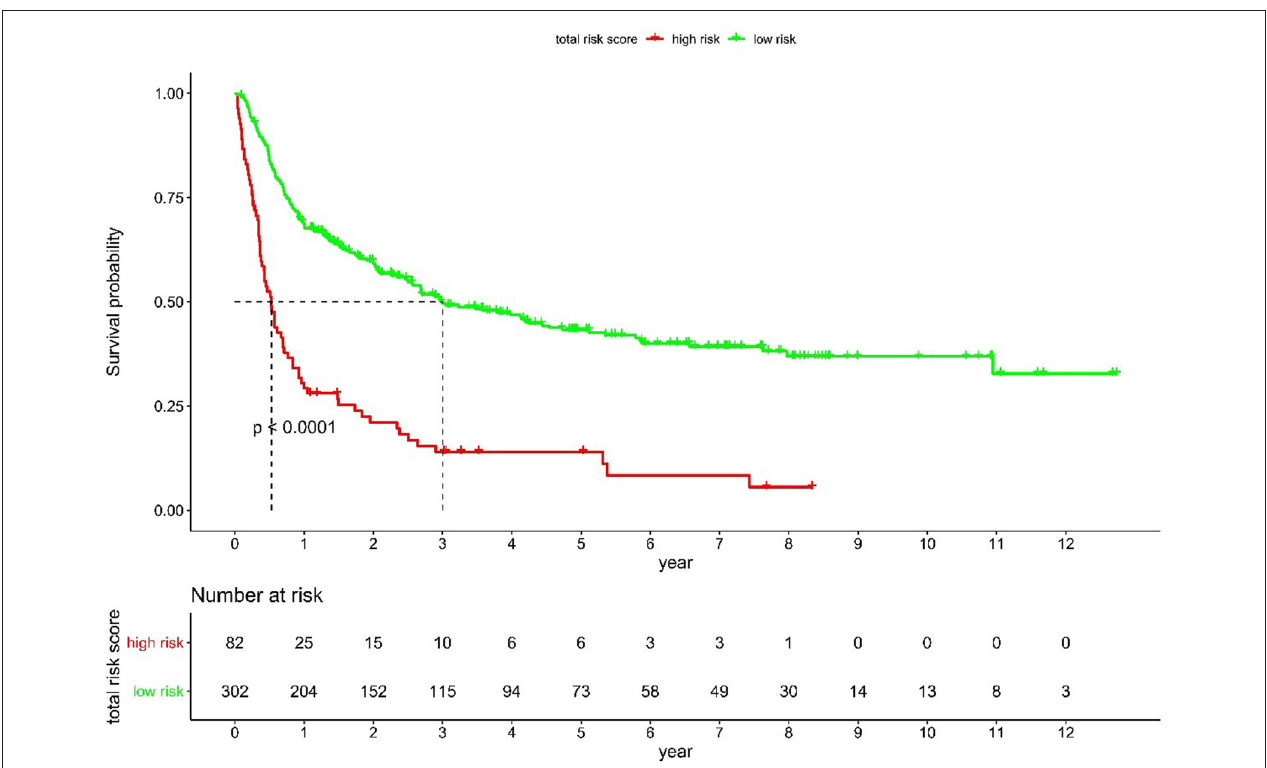
FIGURE 3 | Kaplan–Meier cumulative event rates in the derivation